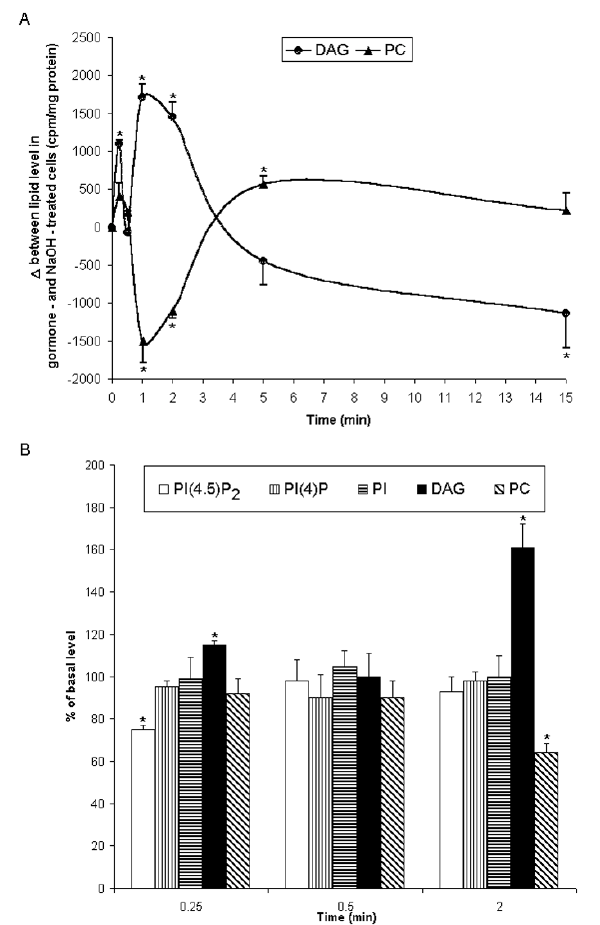
Figure 1 Effect of L-T 4 on [ 14 C]DAG and [ 14 C]phospholipid level in liver slices and isolated hepatocytes. [ 14 C]sodium acetate labeled liver slices (A) and [ 14 C]oleic acid labeled hepatocytes (B) were treated with 100 nM NaOH (control) or 10 nM L-T 4 for indicated times. Lipids were extracted, separated by TLC, and analyzed as described in "Materials and Methods". Basal lipid levels in control cells (Fig. 1B) did not change significantly over the experimental period and were (cpm/10 7 cells): PI -4721 ± 633, PI(4)P - 4265 ± 264, PI(4,5)P2 - 3605 ± 317, PC - 7662 ± 344, DAG - 6008 ± 106. Results represent the mean ± S.E. of four individ- ual experiments. * P < 0.05 vs.